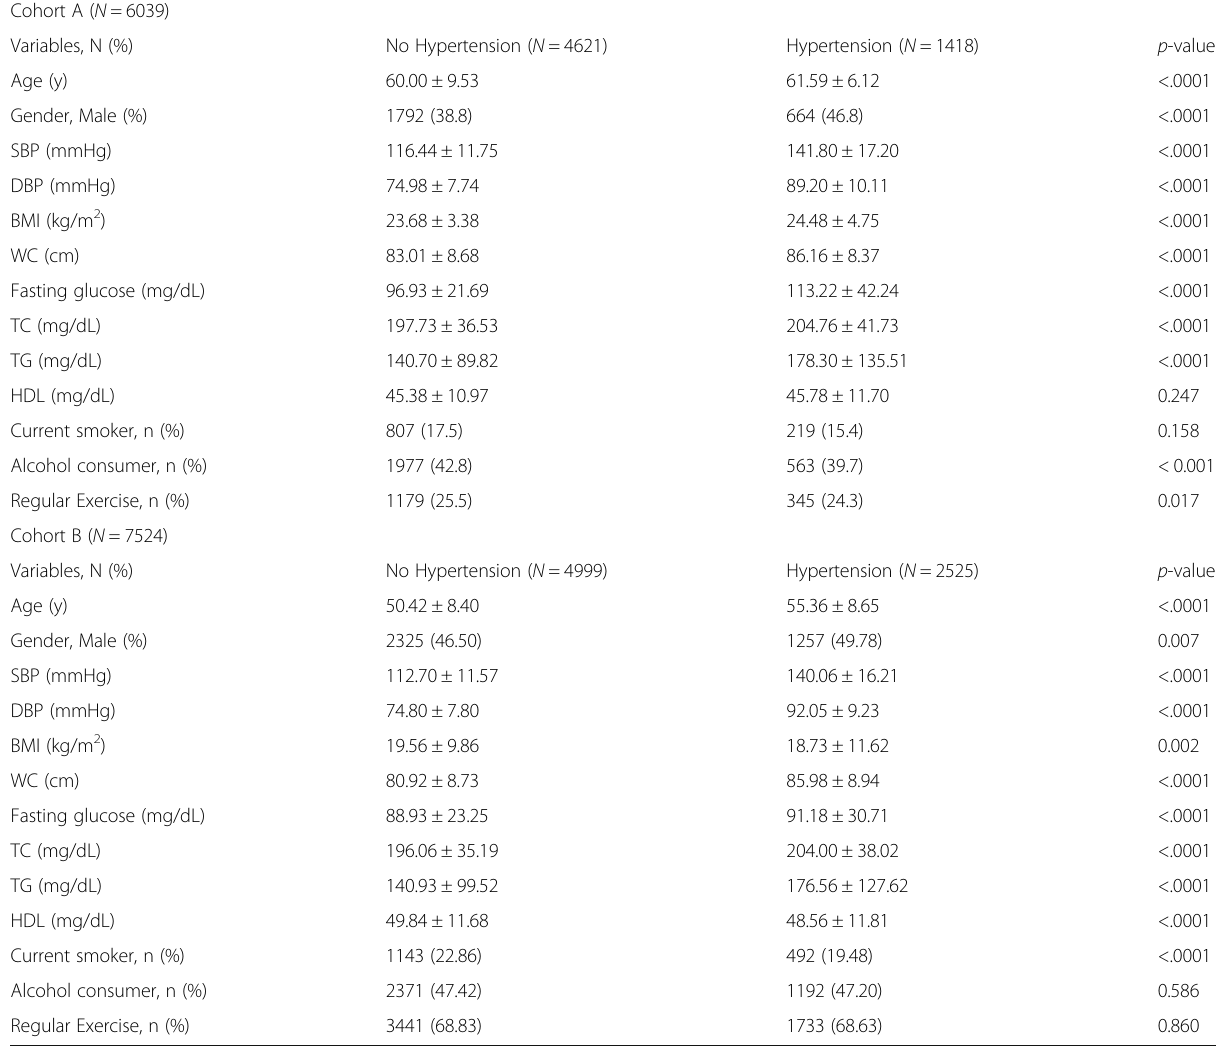
Table 1 Demographic characteristics of study population in cohort A and